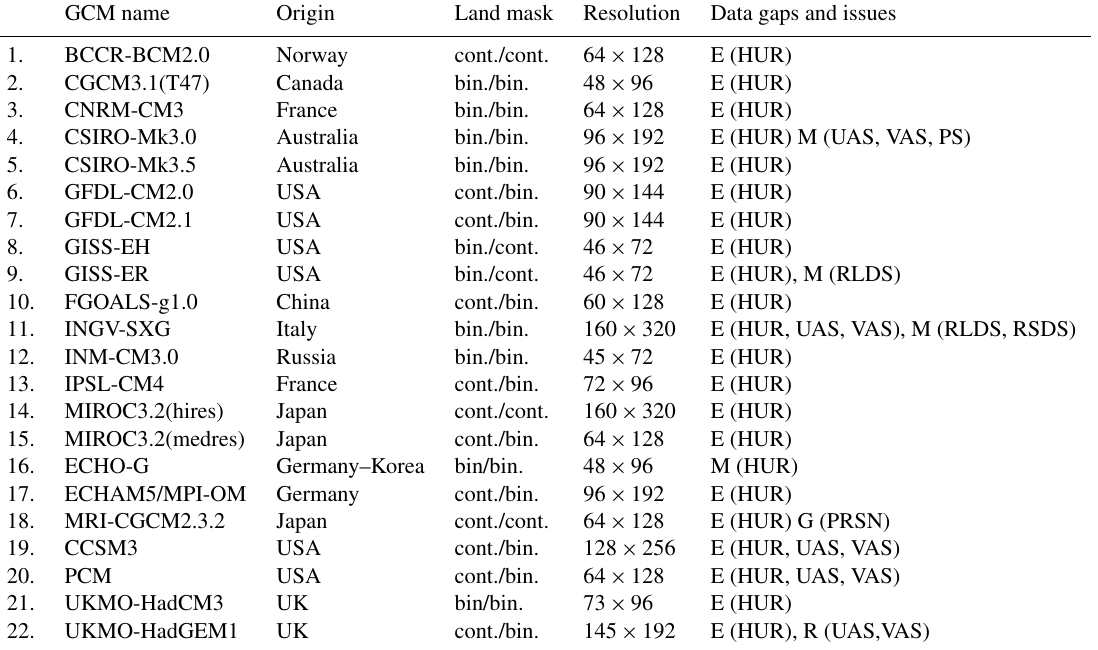
Table 1. Availability of WCRP CMIP3 data for the climate patterns study, and characteristics of models’ depiction of land and water areas (variable sftlf). Land–water transition is either continuous (cont.) or abrupt (binary mask – bin.). The first characteristic in the column “Land mask” pertains to coastlines, whereas the second pertains to inland waters. The codes in column “Data gaps and issues” are as follows: M – missing, E – 4-D variable (surface values need to be extrapolated), G – data gaps, R – some data needed